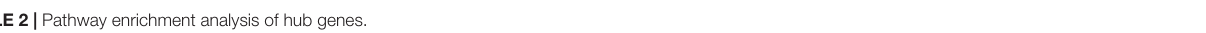
FIGURE 5 | Protein–protein interaction (PPI) network. Each node in the figure represents a protein, and the edge represents the interaction between the two proteins. TABLE 2 | Pathway enrichment analysis of hub